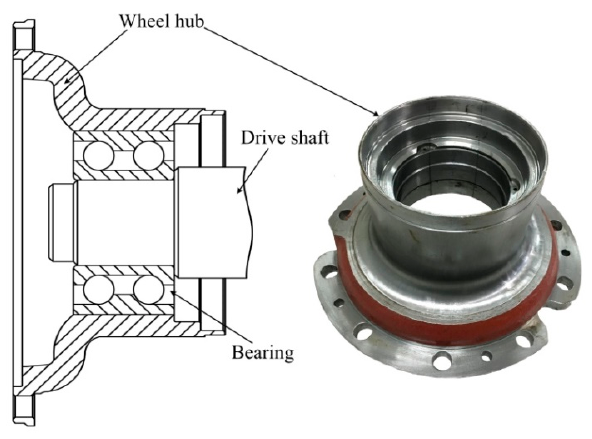
Figure 1. Assembly of a wheel hub with other objects.